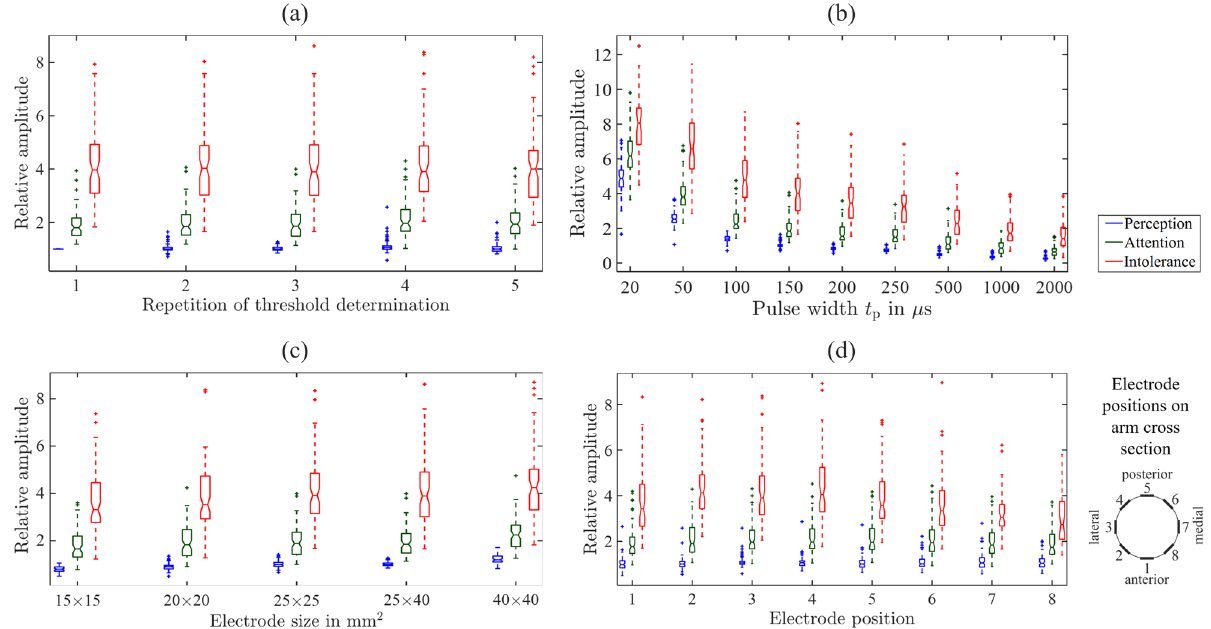
Figure 4. Relative thresholds, normalized by the reference perception threshold as a function of ( a ) repeated threshold determinations during the course of the experiment with electrode pair 3 (25 mm × 40 mm), ( b ) varying pulse widths, ( c ) varying electrode sizes, and ( d ) electrode position. Please note that the x -axis is not to scale for ( b , c